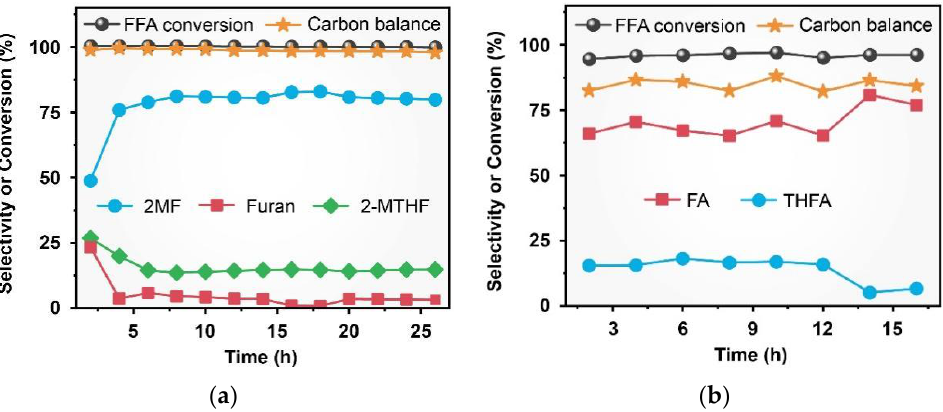
Figure 7. Cu/SiO 2 catalysts for FFA conversion to 2-MF ( a ) Cu/SiO 2 (AE); ( b ) Cu/SiO 2 (CP).